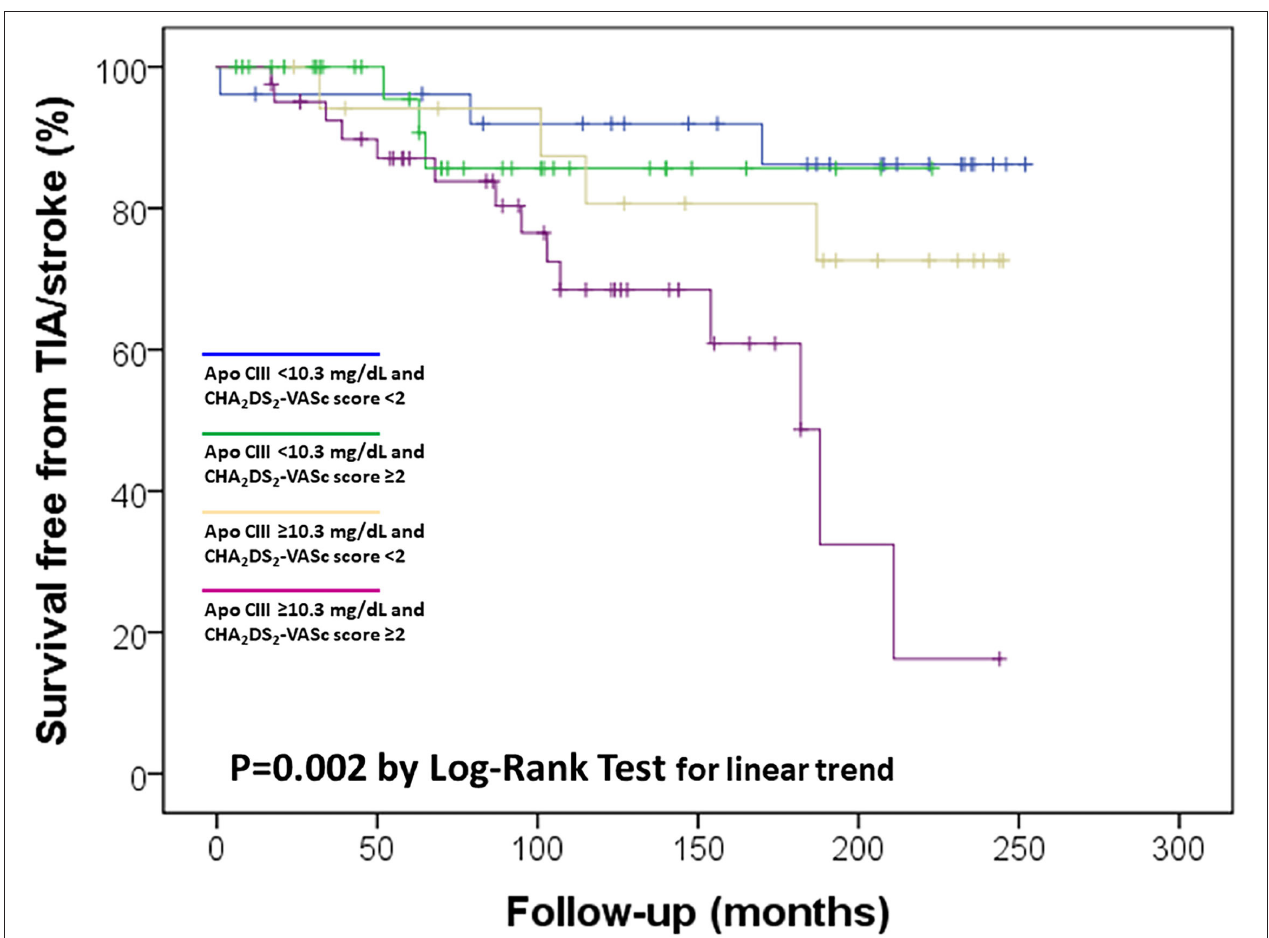
FIGURE 3 | Kaplan-Meier survival curves for ischemic stroke/transient ischemic attack (TIA) in the study sample according to Apolipoprotein C-III (Apo CIII) plasma concentration, with the median level (10.3 mg/dL) as threshold value, and CHA 2 DS 2 -VASc score, with ≥ 2 as threshold value.